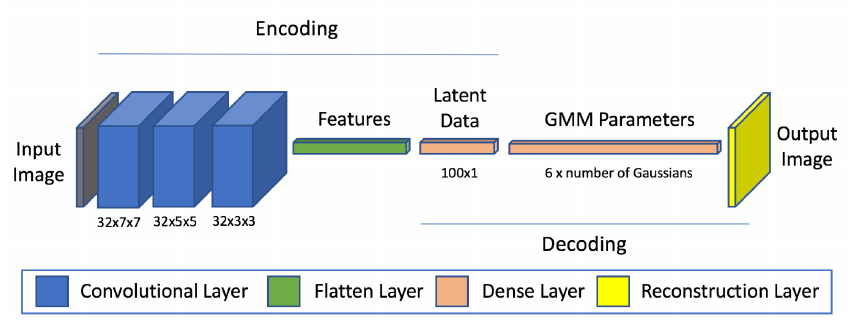
Figure 2. Our two-step approach: first we extract the images latent data representation using a GMM Autoencoder CNN; then we use the CNN output to generate new realistic images using a non-rigid registration schema. .